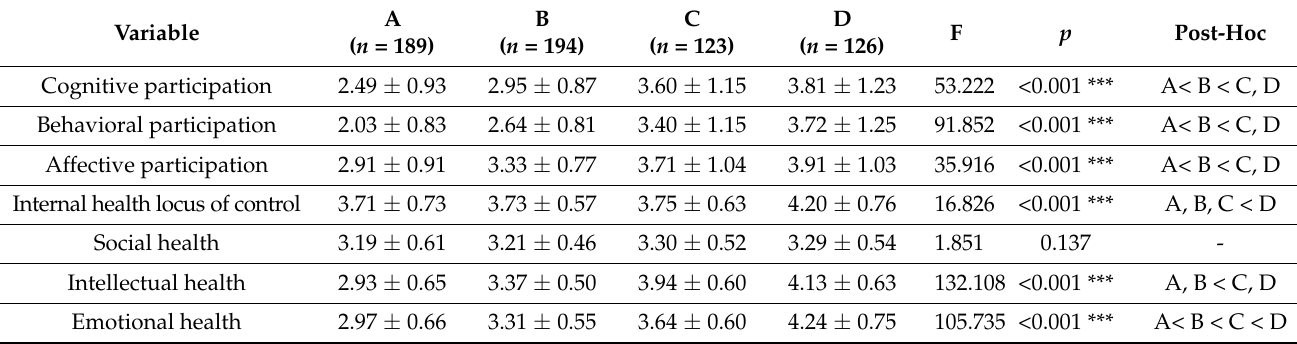
Table 7. Differences in each variable by frequency of sports participation per